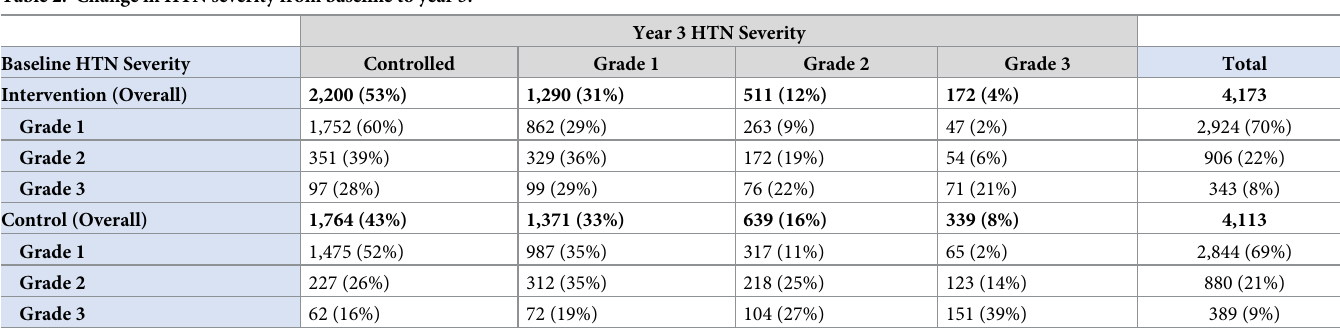
Table 2. Change in HTN severity from baseline to year 3.